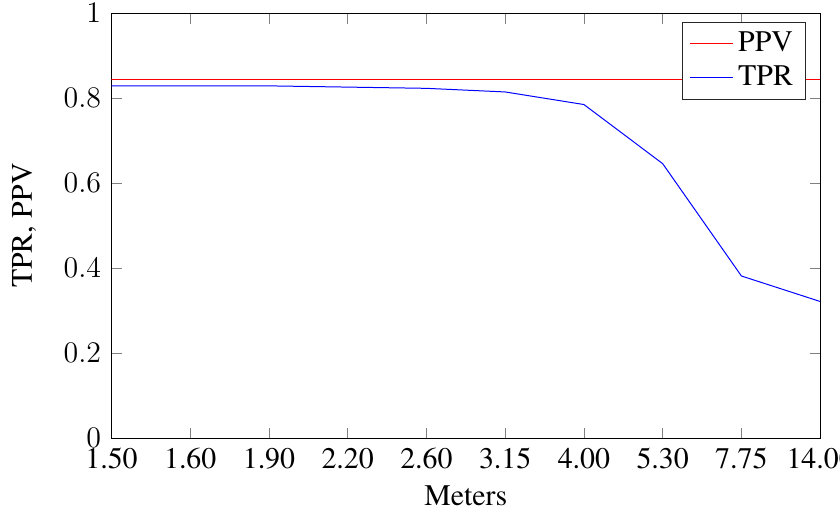
Figure 10. Performance as a function of evaluated distance.